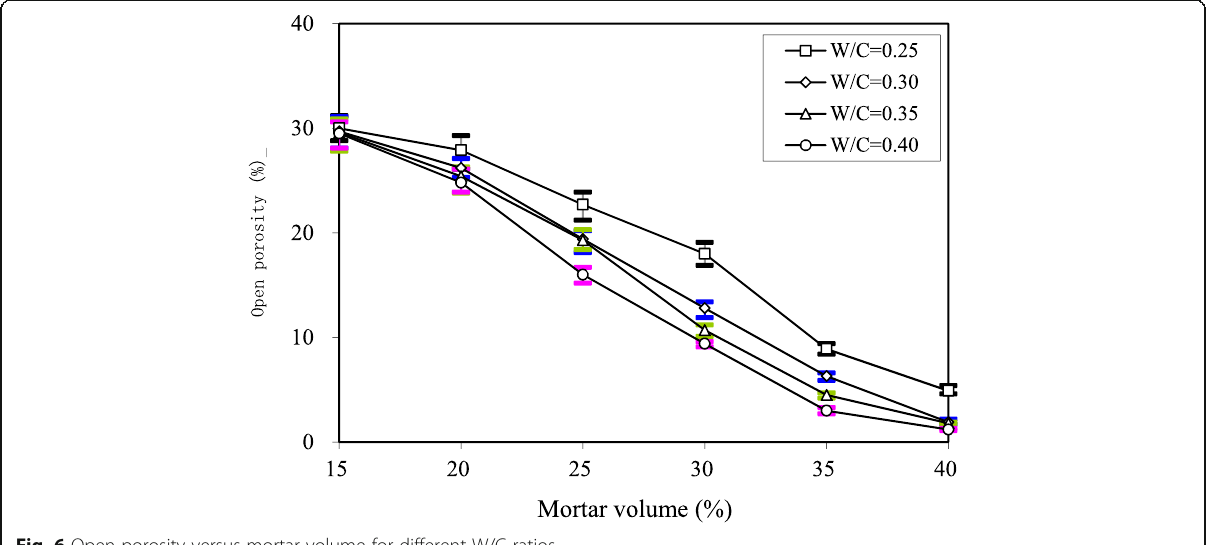
Fig. 6 Open porosity versus mortar volume for different W/C